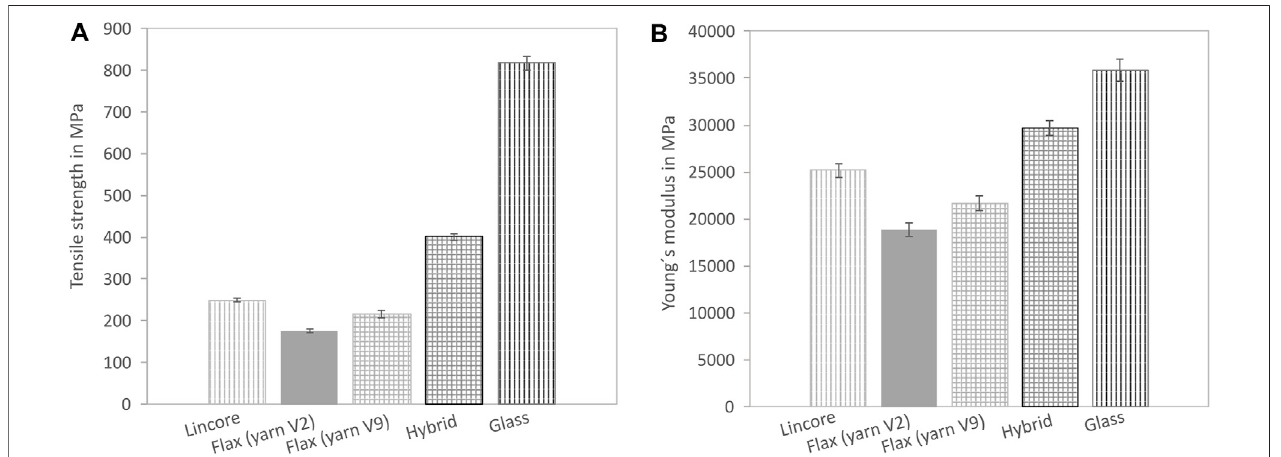
FIGURE 7 | Tensile strength (A) and Young ’ s modulus (B) of composite laminates (mean value ± standard deviation).